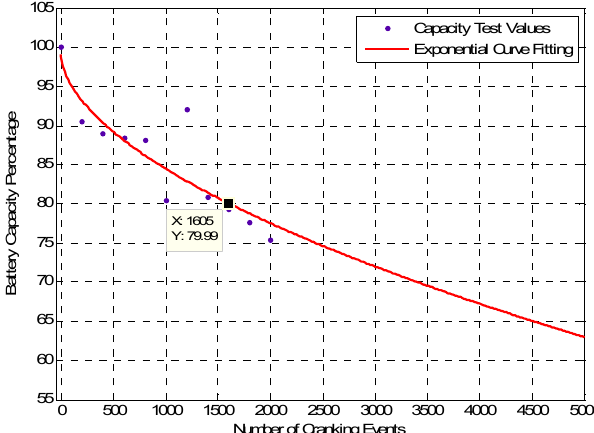
Figure 17. Battery alone capacity versus cranking events with exponential extrapolation.